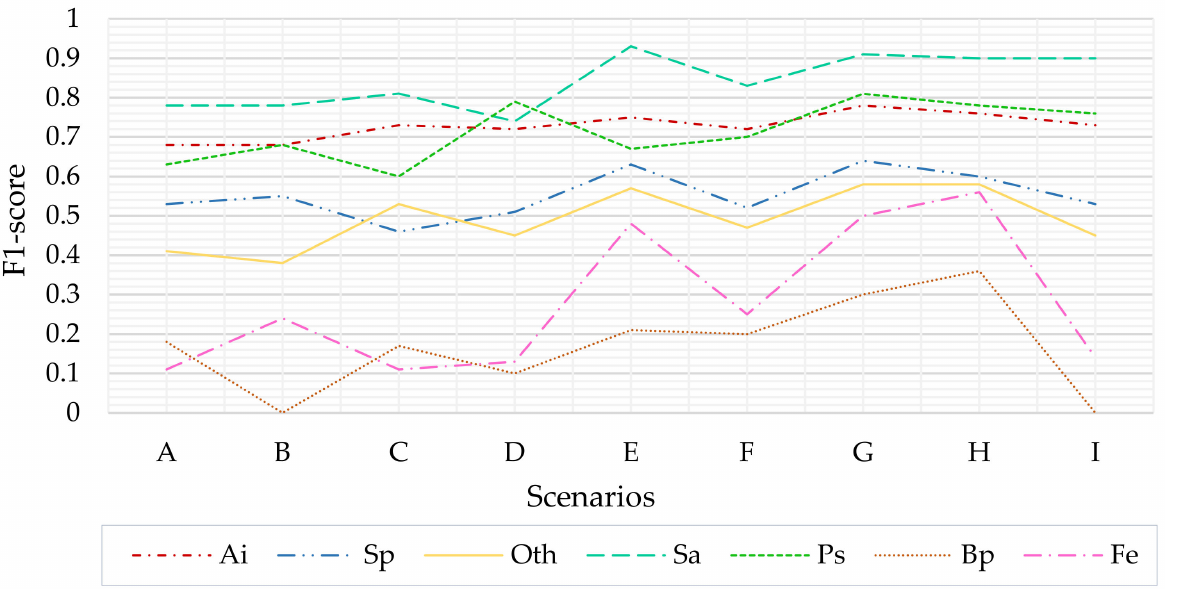
Figure 6. F1-score variability in the analyzed